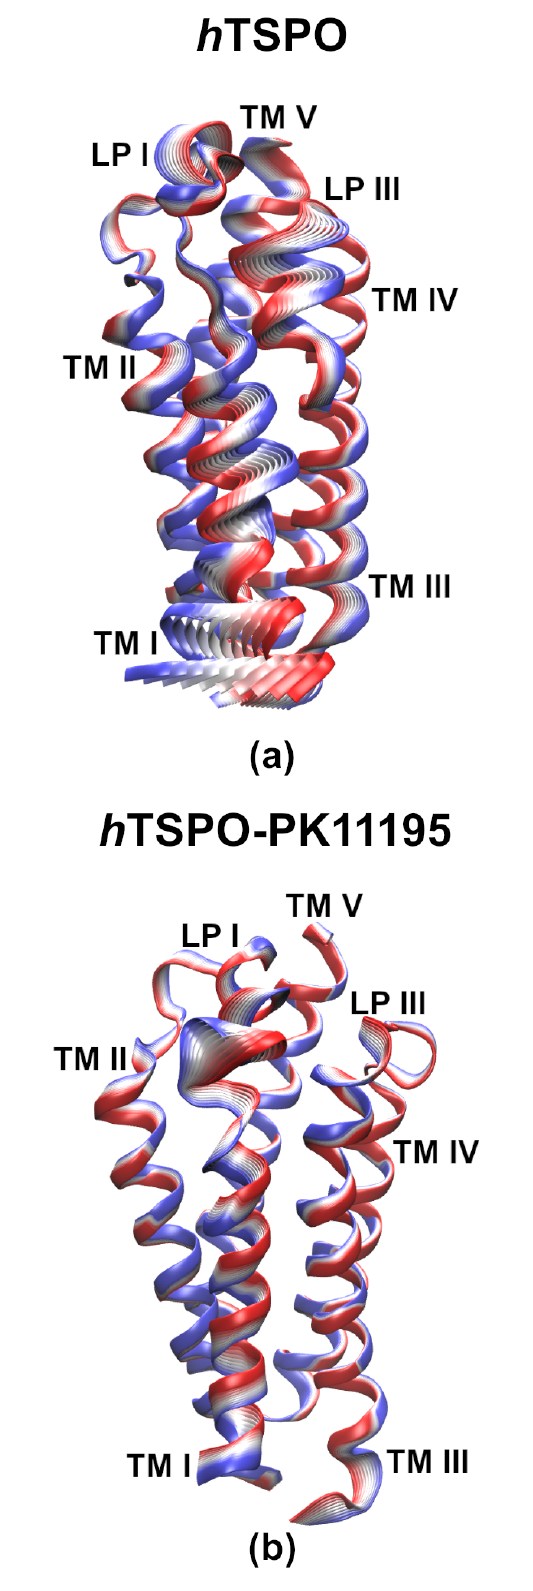
Figure 6. The principal component analysis of the ( a ) h TSPO and ( b ) h TSPO–PK11195 models showing the flexible parts of the protein. The image of every hundredth frame is shown, spanning from the beginning (red color) to the end (blue color) of the MD